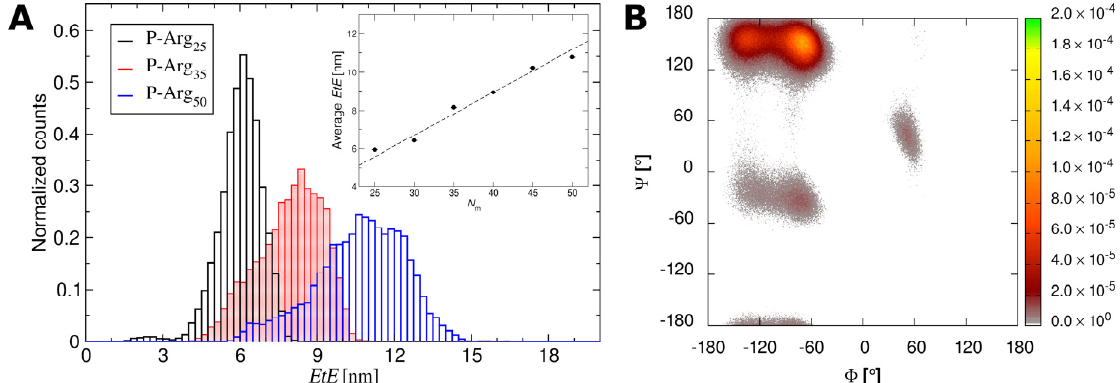
Figure 2. ( A ) The end-to-end distance distribution for N m = 25, 35 and 50 derived from MD modeling (NaCl concentration equal to 10 − 3 M). The inset shows the average P-Arg end-to-end ( EtE ) length as a function of the number of monomers. The dashed line denotes linear fitting—using Equation (1). ( B ) Ramachandran plot for P-Arg 50 calculated from the molecular dynamics simulations showing the distribution of the Ψ and Φ angles of the peptide